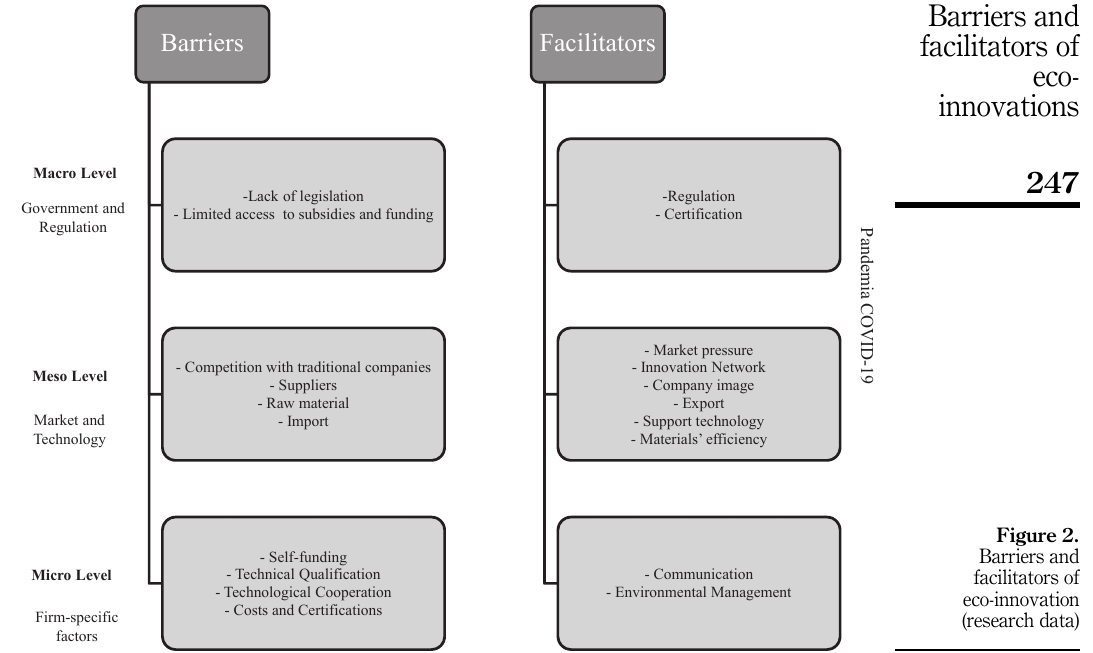
Figure 2. Barriers